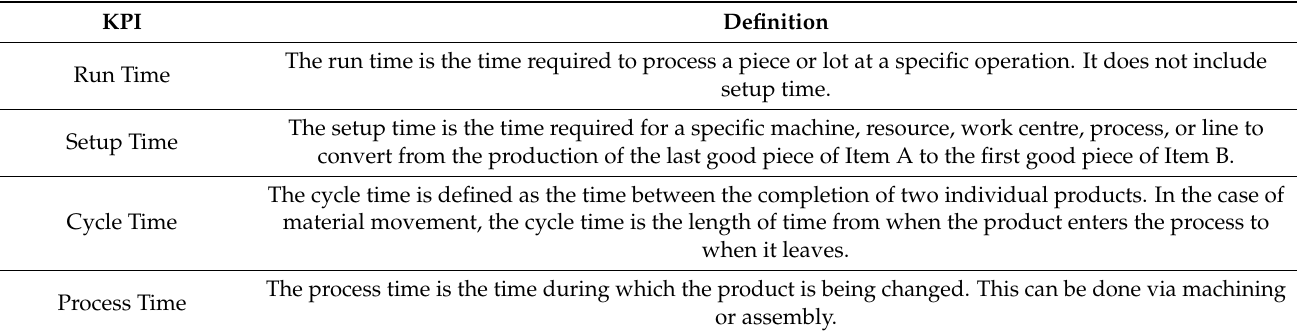
Table 2. Definition of the Used KPIs